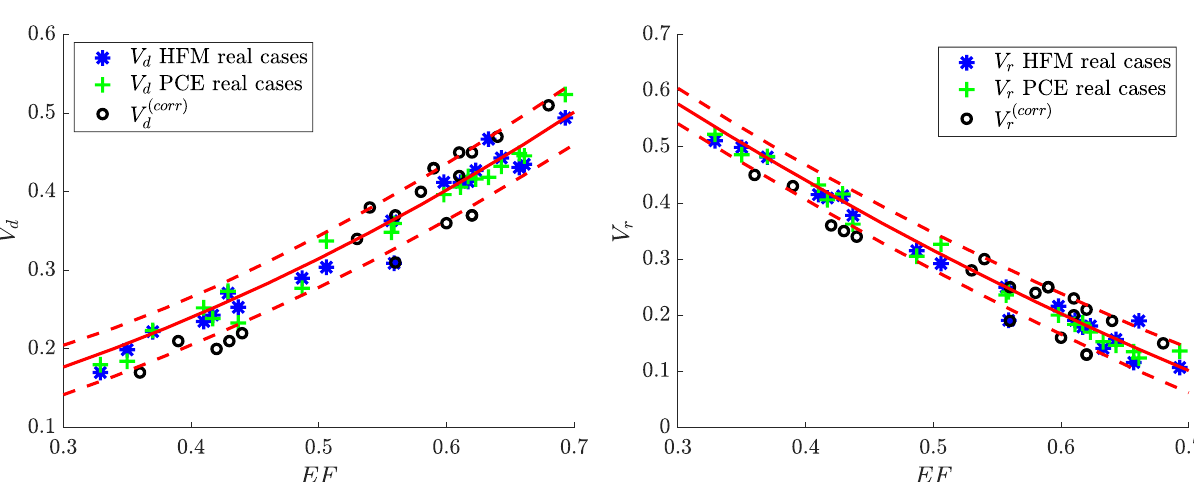
Figure 5. V d and V r against EF for the 20 patient-specific (real) cases analysed in this study and based on the predictions provided by the HFM and the PCE-based surrogate models. Other cases derived from literature, V ( corr ) V ( corr ) r , are also represented in their modified version after correction for the regurgitating volume. d and The red continuous line represents the mean of the QoI (either V d or V r ) against EF obtained with the surrogate model, given the variability of the remaining parameters (red dashed lines represent the 1% and 99%